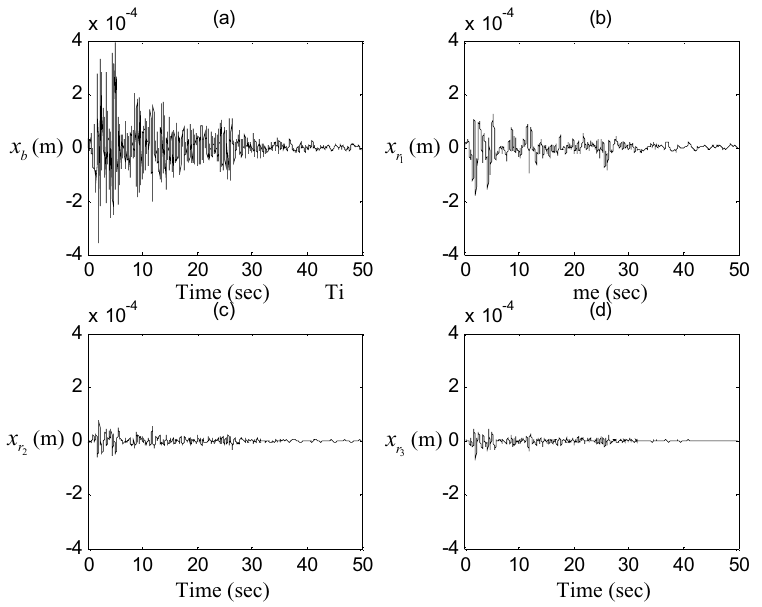
Fig. 3. Relative displacements associated with the LQR-controlled response. (a) Passive element x r 1 = x p ; (b) First mass x r 2 = x 1 ; (c) Second mass x r 3 = x 2 − x 1 ; (d) Third mass x r 4 = x 3 − x 2